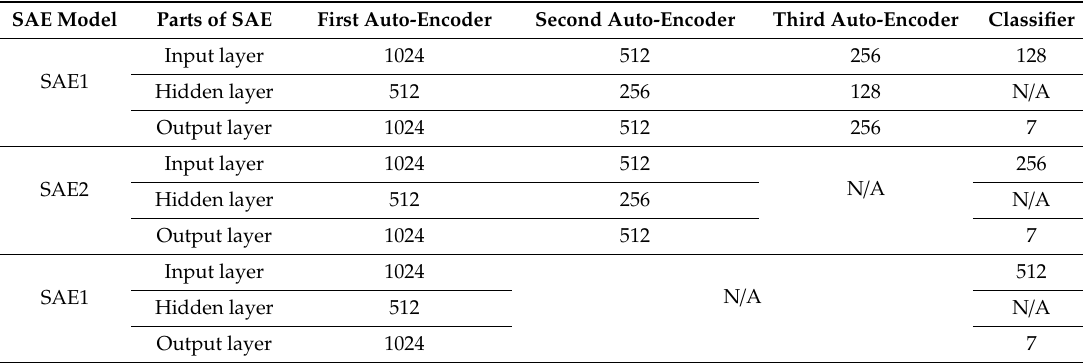
Table 5. The structure of the stacked autoencoder (SAE) model for radar emitter signal recognition.